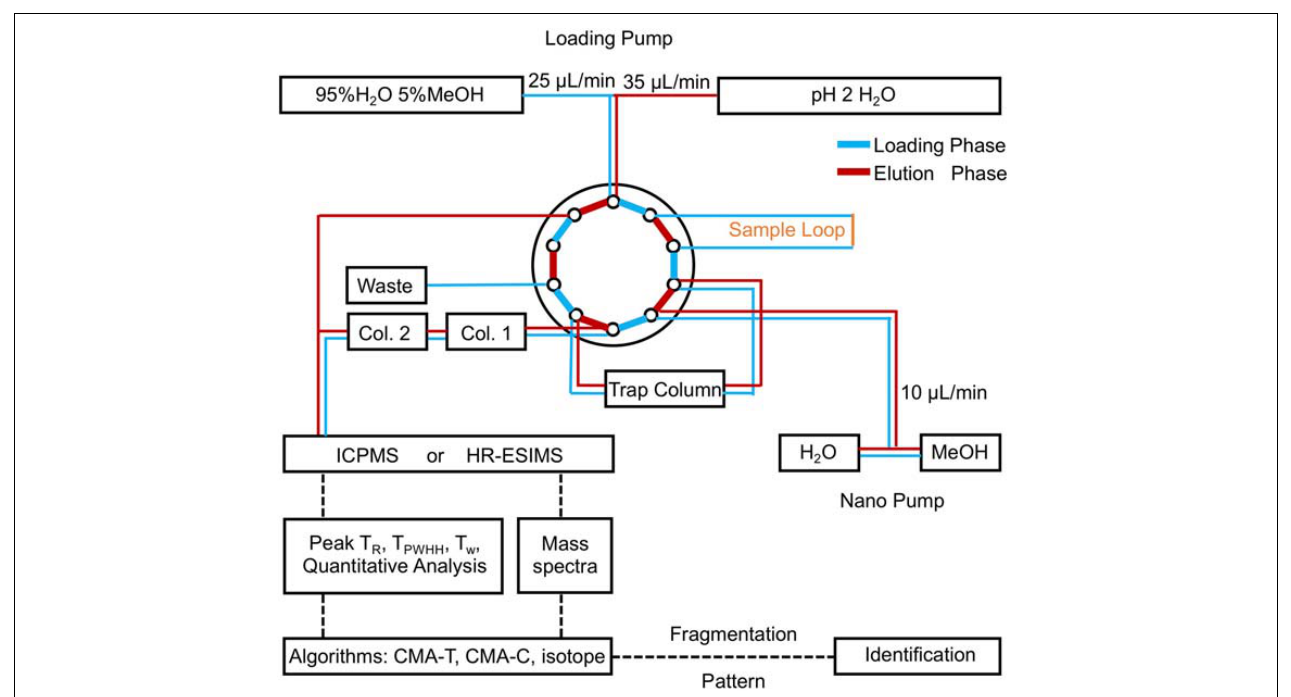
FIGURE 2 | Schematic of the low-flow/make-up flow LC-MS instrumentation. Samples are picked up by the injector and loaded onto the trap column by the loading pump. Once loading is complete, the 10 port-valve switches to the nano-pump, which pushes the sample onto the columns, and elutes it using a gradient of aqueous methanol. During the elution phase, the loading pump flow is redirected to deliver a make-up flow that is post column infused, before entering ICPMS. The LC-ICPMS data are used to target nutrient metabolites by retention time and peak width. Companion ESIMS data are then queried by algorithms to assign masses, elemental formula, and MS 2 spectra of nutrient